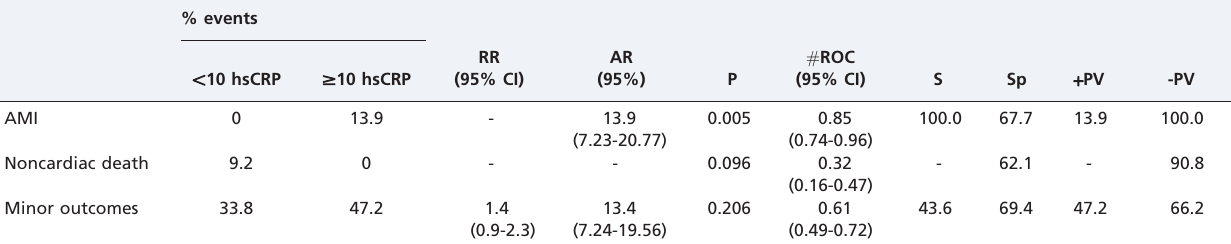
Table 3 - Relative risk, absolute risk, sensitivity, specificity, and positive and negative predictive values for the cut-off point of $ 10 mg/L